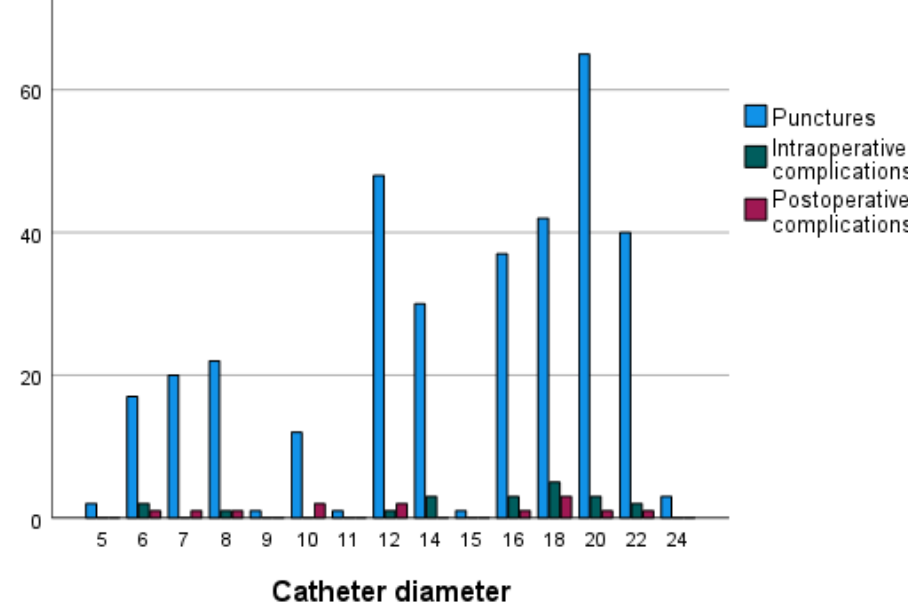
Figure 1. Number of intraoperative and postoperative complications with regard to introduced sheath diameter.